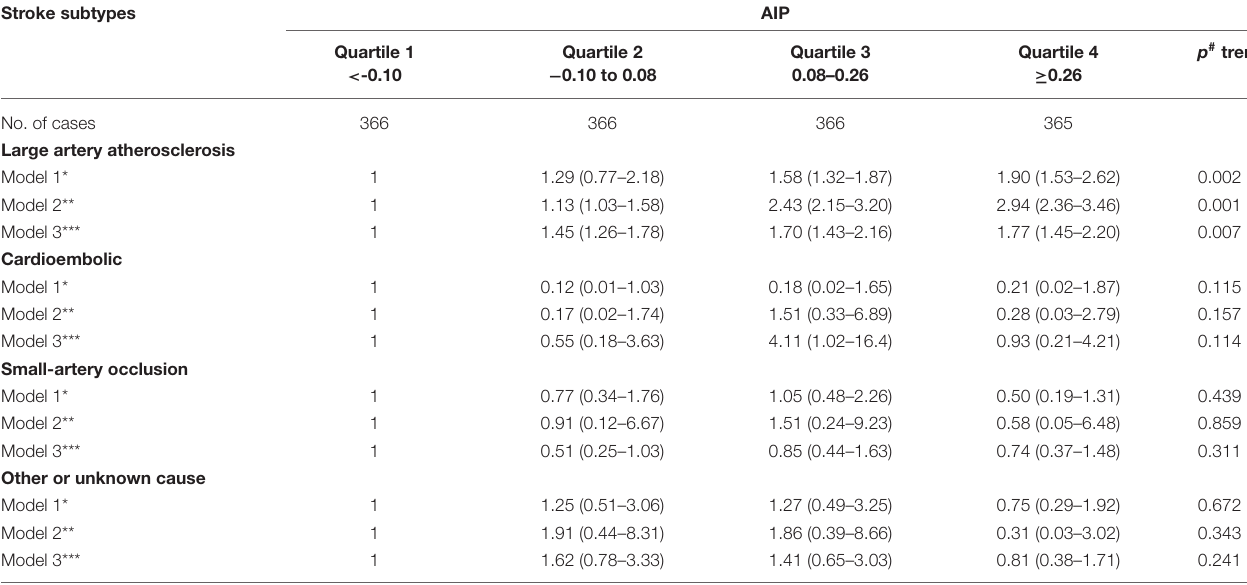
TABLE 3 | Adjusted odds ratios of outcomes according to AIP in stroke